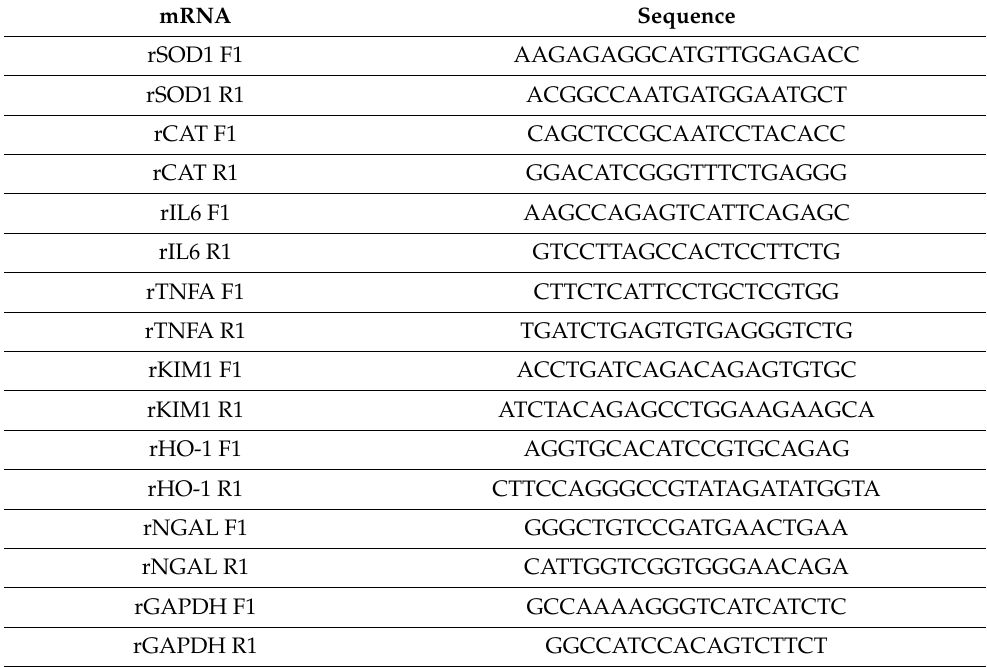
Table 1. List of the primers used in qRT-PCR analysis.